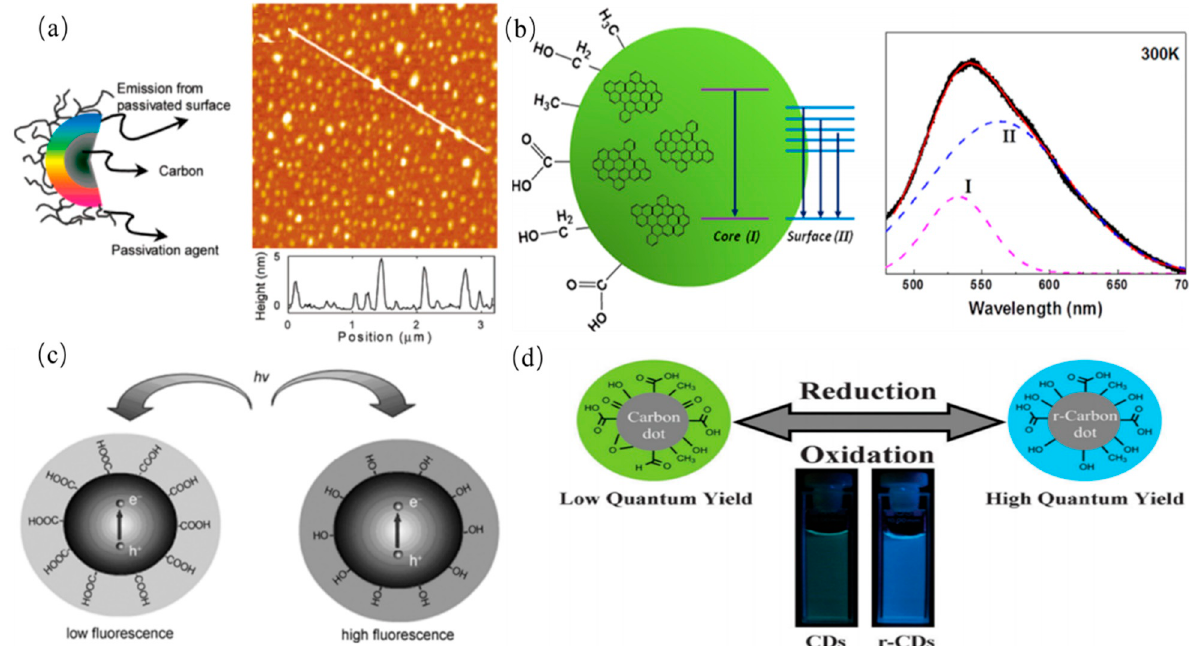
Figure 14. ( a ) Surface state and carbon-core state in CQDs [131]. Copyright 2007, American Chemical Society. ( b ) Dual fluorescence bands observed in CQDs [132]. Copyright 2012, American Chemical Society. ( c ) Graphical comparison about effect of electron-withdrawing and electron-donating surface functional groups on CDs PL [133]. Copyright 2011, Springer Nature. ( d ) Diagram about oxidation/reduction of surface functional groups to alter the luminescence of CDs [134]. Copyright 2011, Royal Society of Chemistry.